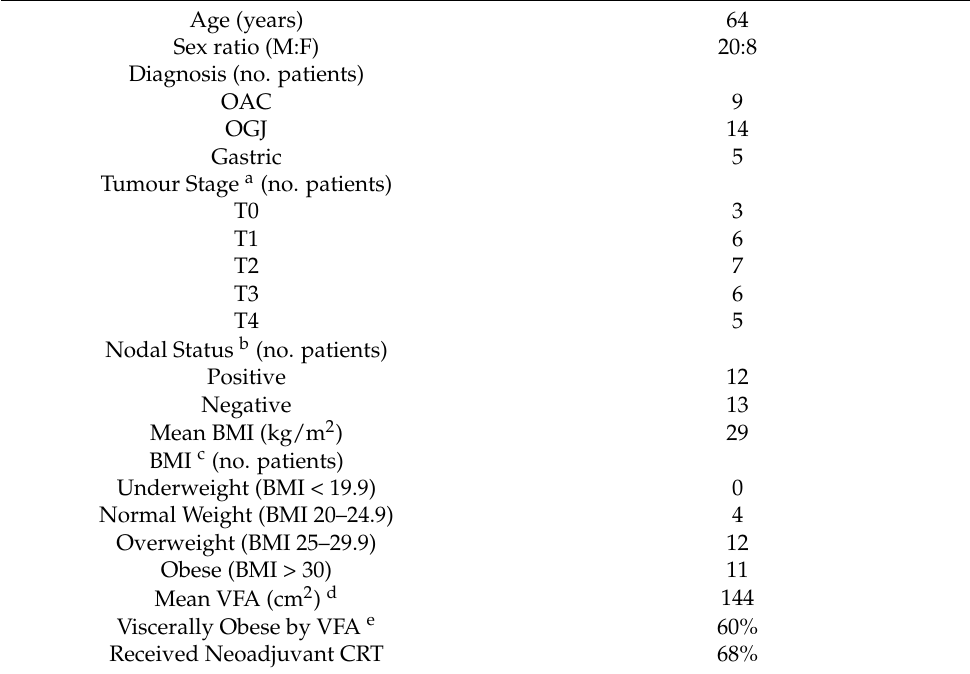
Table 1. Patient